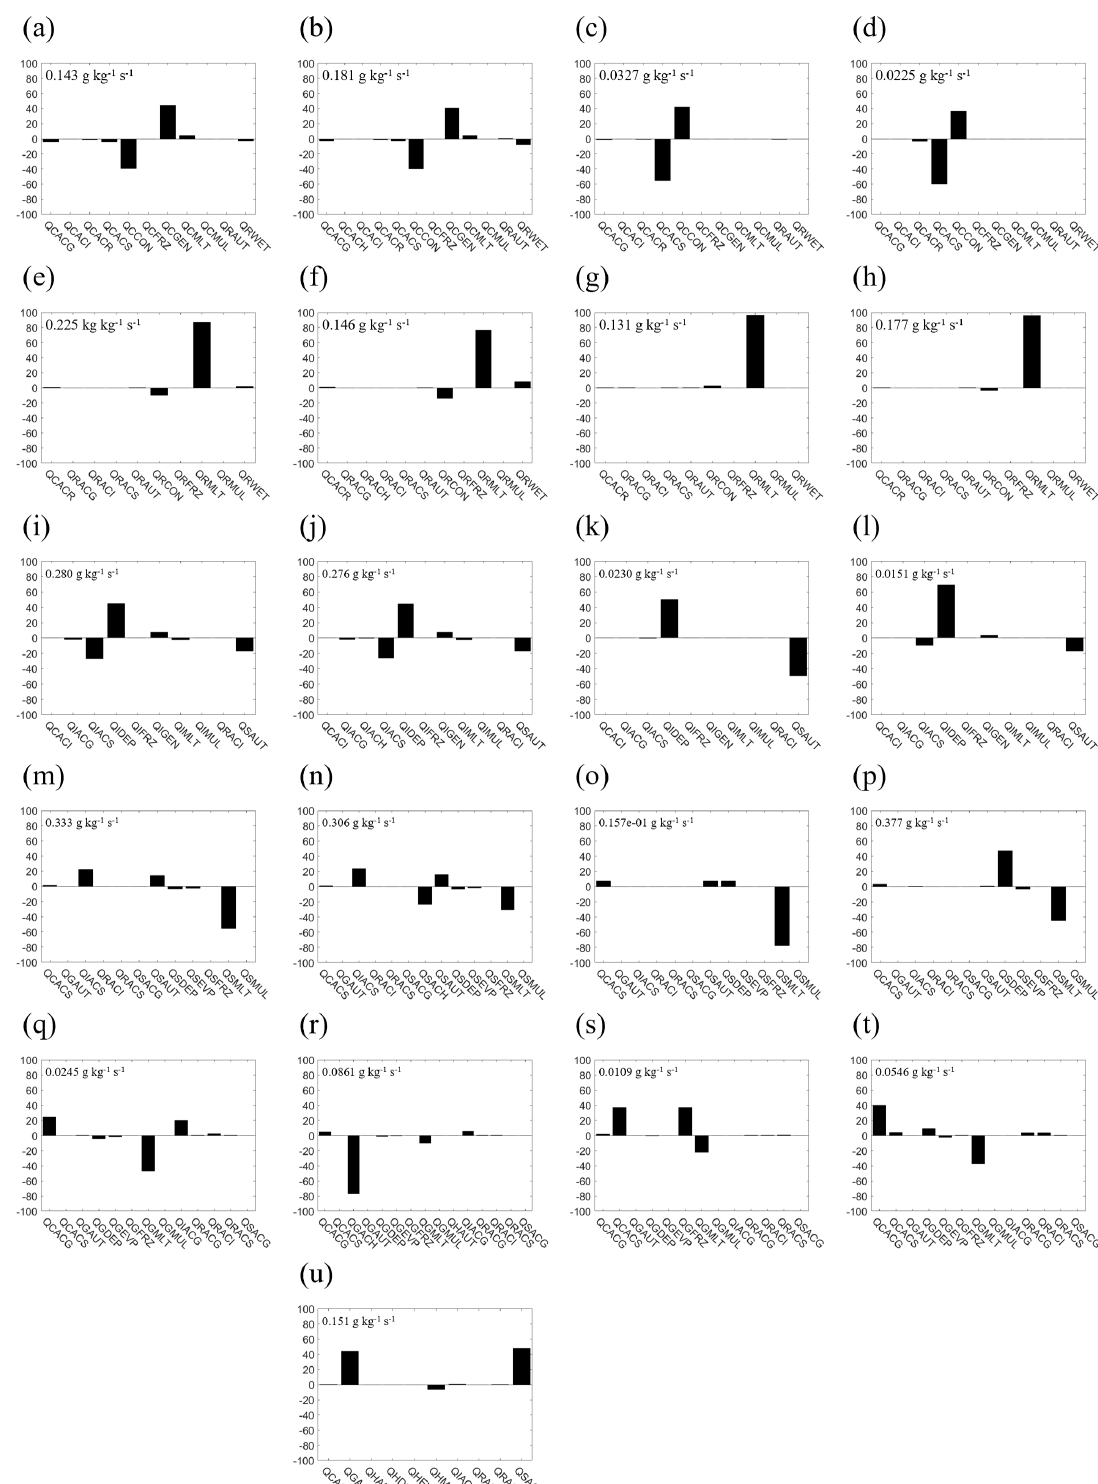
Figure 11. The same as Fig. 9 but representing the results for case